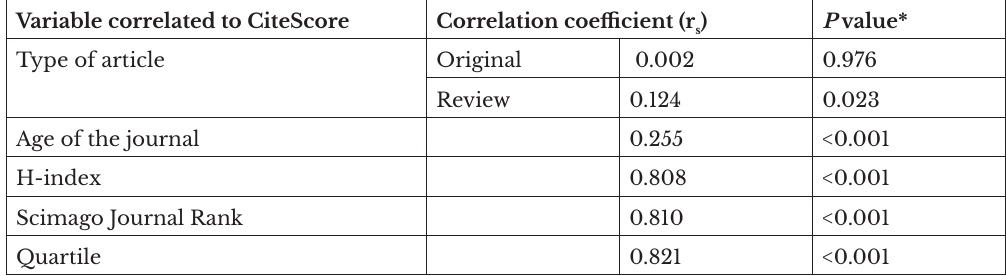
Table 2. Correlation between CiteScores of cardiology journals indexed in Scopus and type of articles, age of the journal, H-Index, Scimago Journal Rank, or quartile Variable correlated to